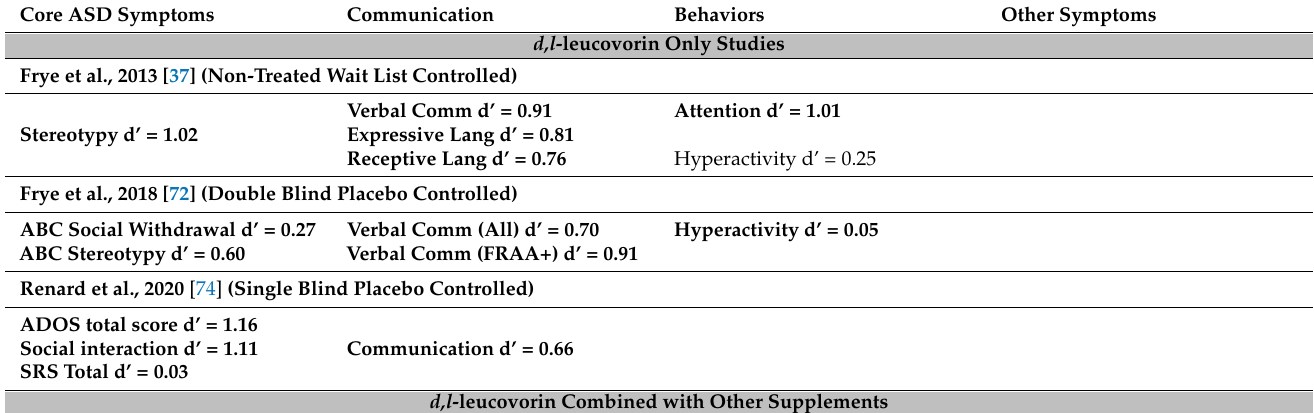
Table 4. Outcome measures represented in effect size in key studies which have used d,l -leucovorin. Cohen’s d’ was calculated for studies which provided enough information to make such calculations. For controlled studies, the effect size represented the difference between the treatment and the control group, whereas for uncontrolled studies, the effect size was calculated only for the treatment. Effect sizes were considered small if Cohen’s d’ was 0.2; medium for Cohen’s d’ of 0.5, and large if Cohen’s d’ was 0.8. Effects in bold are statistically